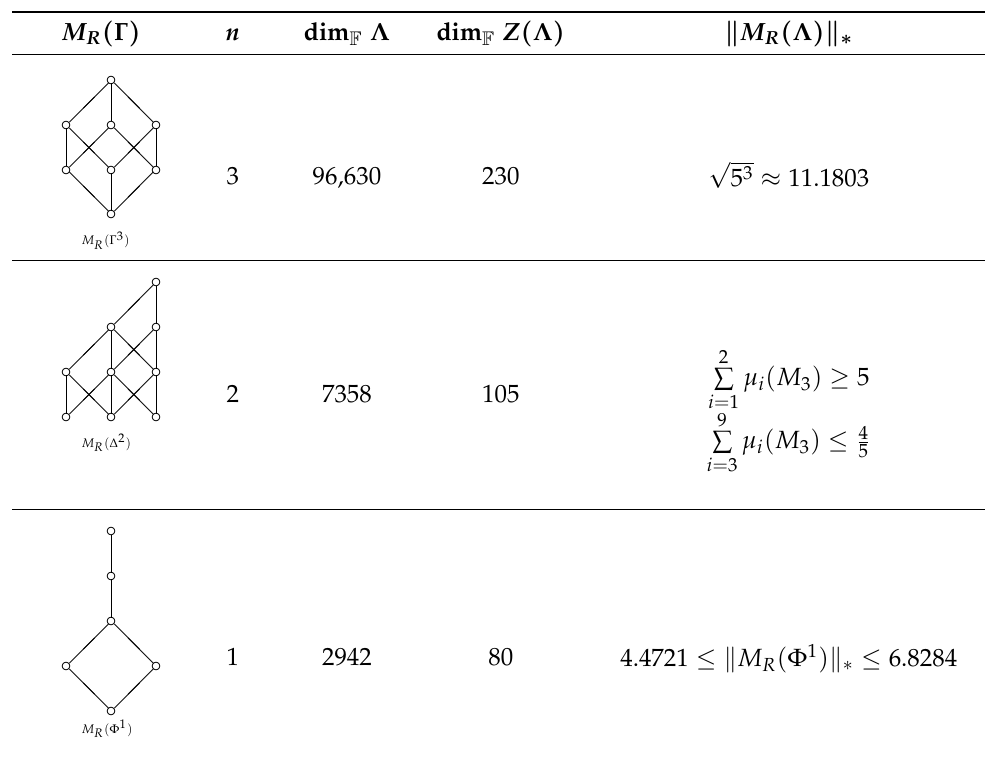
Table A1. This table shows the graphical representation of reduced messages of the Brauer configura- tions Γ 3 (14), ∆ 2 (7) and Φ 1 (19). The dimension of the corresponding Brauer configuration algebras and their centers together with trace norm